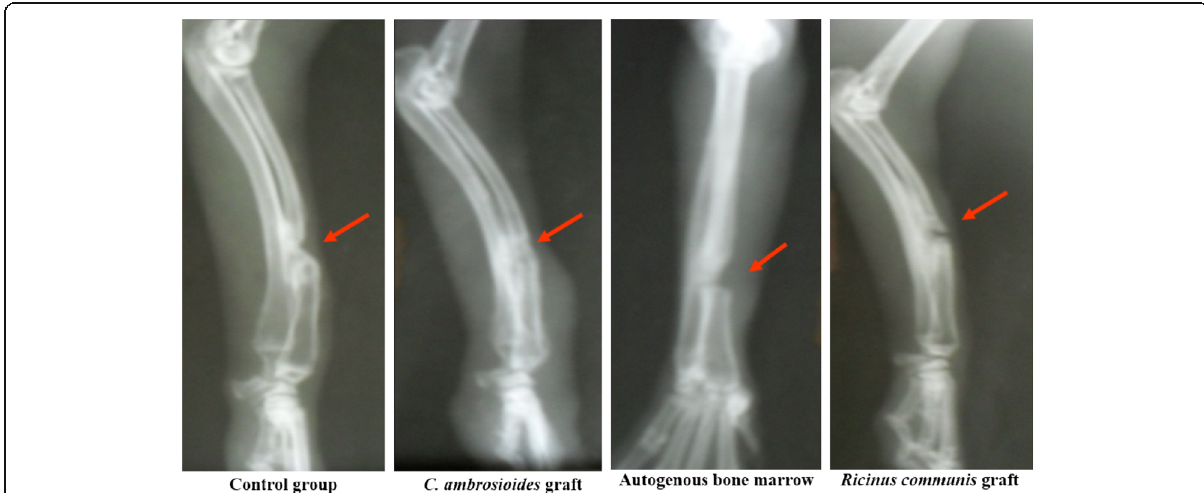
Fig. 2 Effect of a graft of lyophilized aqueous Chenopodium ambrosioides L. extract on bone formation. Radiographs showing bone callus evolution after 60 day. Control group: Bone defect exhibiting the formation of a fibrous bone callus. C. ambroioides graft: Formation of a fibrous bone callus throughout the fracture line. Autogenous bone marrow: Bone defect exhibiting the beginning of formation of a fibrous bone callus. Ricinus communis graft: Bone defect exhibiting the formation of a fibrous bone callus and retraction of the fracture line